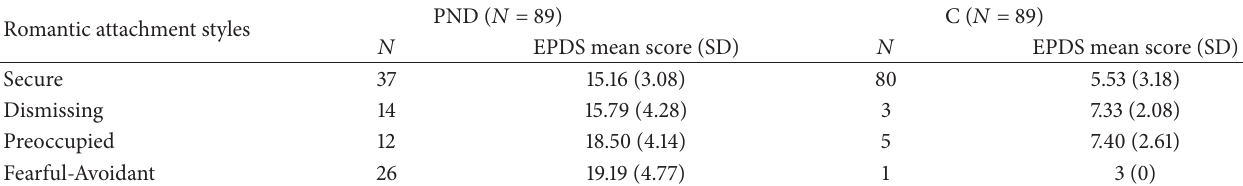
Table 4: Correlations between romantic attachment styles and the EPDS score in both groups ( ∗ ). PND ( 𝑁 = 89) C ( 𝑁 = 89) Romantic attachment styles 𝑁 EPDS mean score (SD) 𝑁 EPDS mean score (SD) Secure 37 Dismissing 14 Preoccupied 12